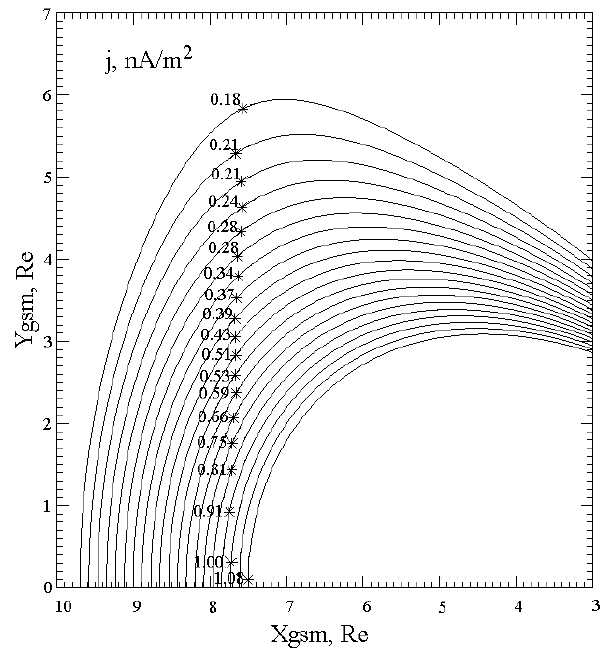
Fig. 3. Positions of minima of the magnetic field at the daytime magnetic field lines and calculated transverse current densities in the regions of magnetic field